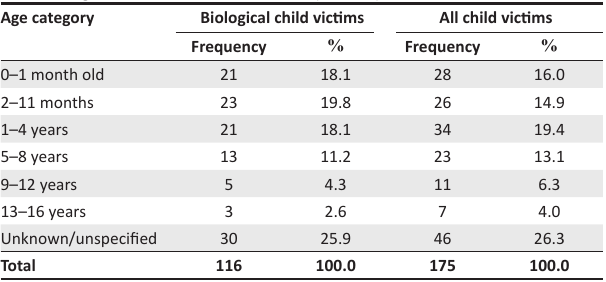
TABLE 3: Motive for offences against offenders’ own child ( n = 116). Motive TABLE 4: Age distribution of child victims ( n =